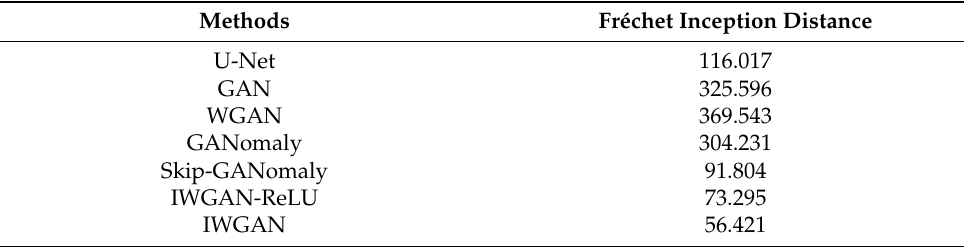
Table 3. FID comparison.